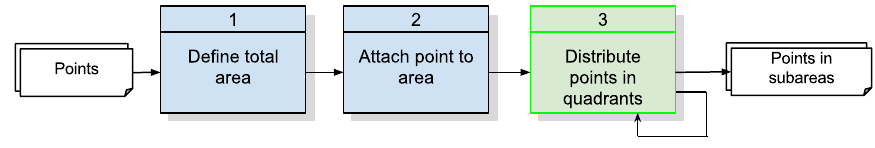
Figure 9. Algorithm 1.1: distribution of points into subareas. Source: the authors.